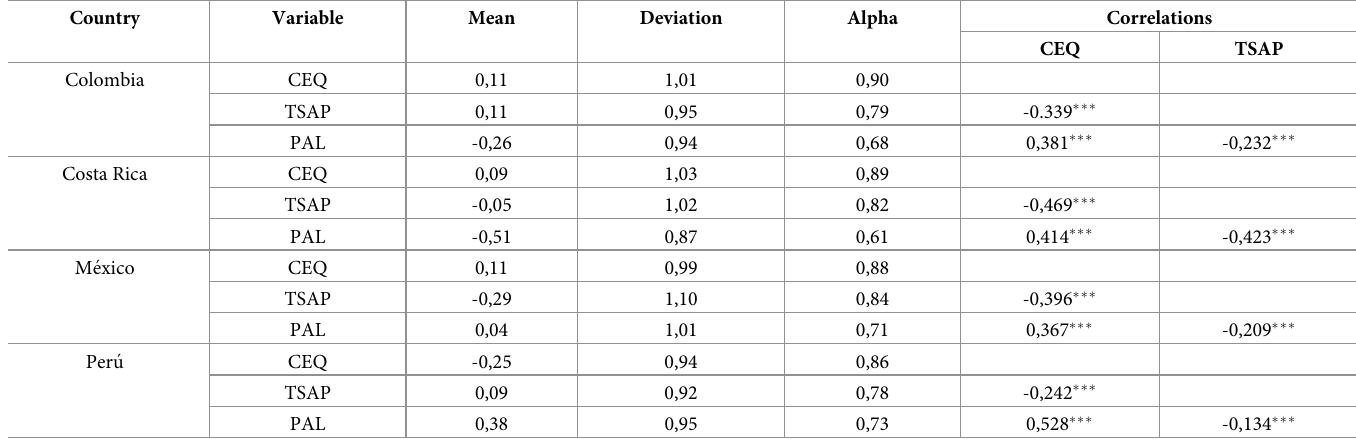
Table 5. Descriptive